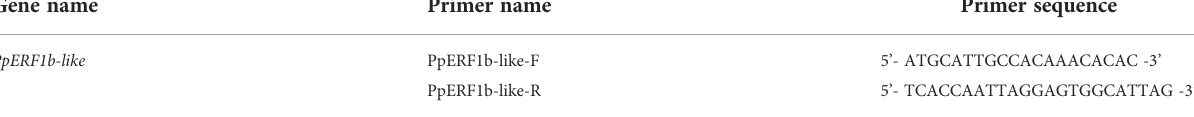
TABLE 2 Primers used for PCR ampli fi cations of PpERF1b-like gene from pear genomic DNA.